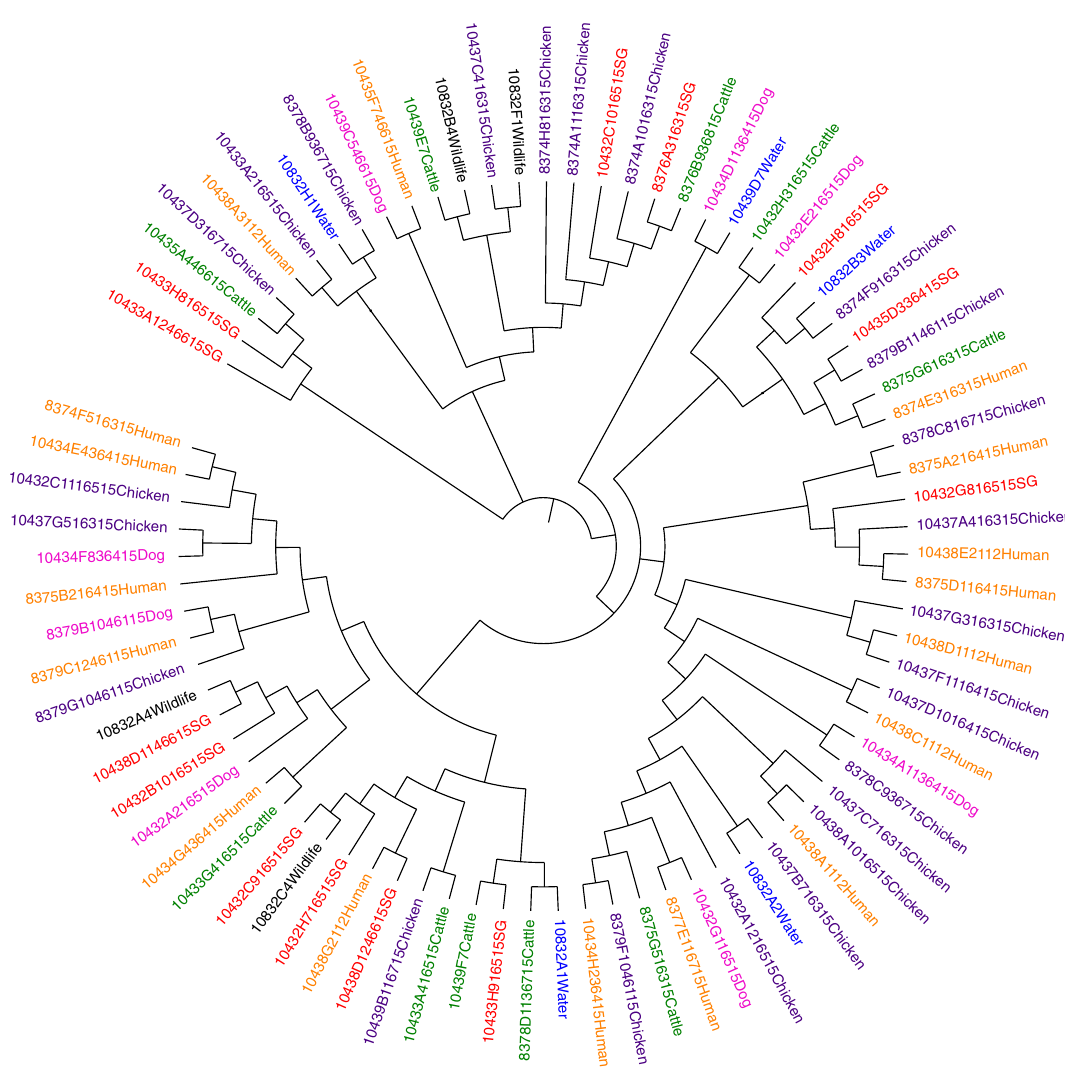
Fig. 5 Phylogenetic tree derived from 81 E. coli isolates. Isolates were collected from eight selected Maasai households and also include wildlife and waters isolates. No clustering of isolates was apparent based on host species or households. Labels show barcode id, house id, year of collection, and host name (e.g. 10435D5466Human; 10435D5 — barcode id, 466 — household id, and Human — host